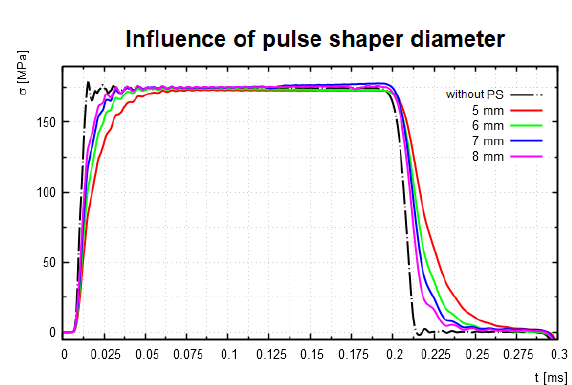
Figure 9. Influence of the pulse-shaper geometry